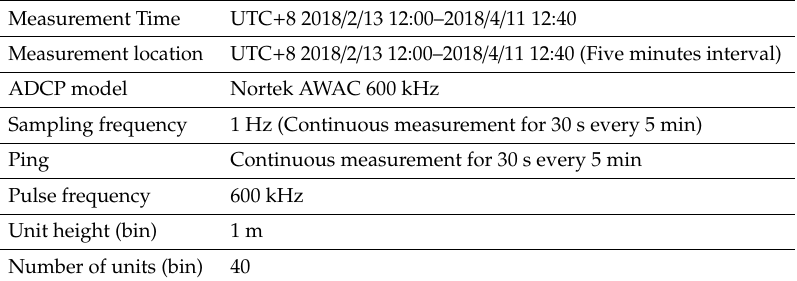
Table 1. The sampling parameters of acoustic doppler current profiler (ADCP).